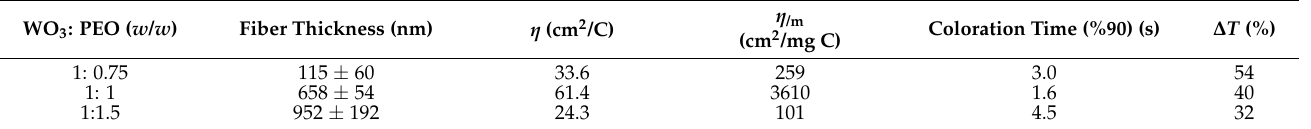
Figure 3. Scanning electron microscopy images of a porous film of WO 3 @PEO fibers with WO 3 :PEO ratios of ( a ) 1:0.75; ( b ) 1:1; ( c ) 1:1.5; ( d , e ) electrochromic characteristics of ECDs based on a porous film of WO 3 @PEO fibers with WO 3 :PEO ratios of 1:0.75 (red), 1:1 (blue), and 1:1.5 (black); ( d ) transmittance profiles at 700 nm wavelength; ( e ) current density plotted against time; ( f ) optical density plotted against charge density are also shown. The applied voltage was − 2 and 1 V in the colored and bleached states, respectively. Table 2. Electrochromic characteristics of the Porous Film of WO 3 @PEO-fiber-based ECD for different WO 3 :PEO